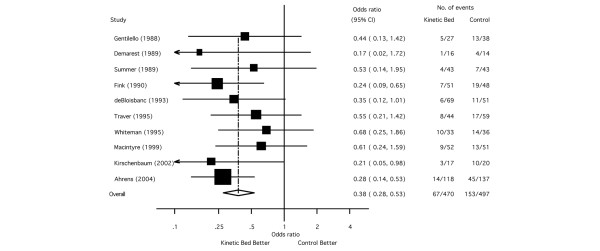
Forest plot showing the effect of kinetic bed therapy on nosocomial pneumonia